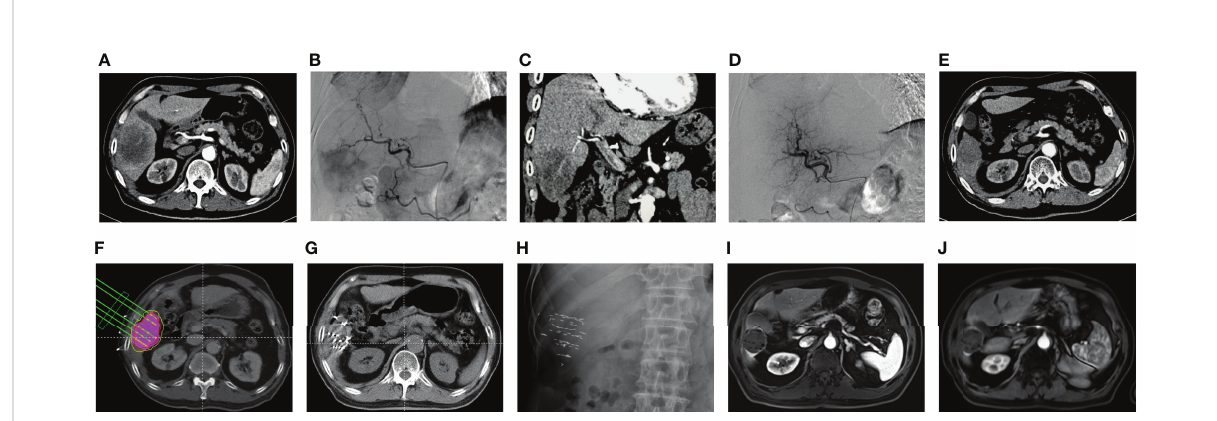
FIGURE 2 A typical case. Enhanced CT (A) , intraoperative DSA (B) , and DSA 3D reconstruction (C) focusing on liver metastases before CSM-TACE. DSA focusing on liver metastases after CSM-TACE (D) . Enhanced CT focusing on liver metastases 1 month after the third round of CSM-TACE (E) . Simulation plan before 125 I brachytherapy (F) . Intraoperative CT focusing on liver metastases immediately after 125 I brachytherapy (G) . Abdominal X-ray focusing on liver metastases 3 days after 125 I brachytherapy (H) . Enhanced MRI focusing on liver metastases 1 year (I) and 2 years (J) after integrated interventional therapy. CSM-TACE, CalliSpheres ® microsphere transarterial chemoembolization; CT, computed tomography; DSA, digital subtraction angiography; MRI, magnetic resonance